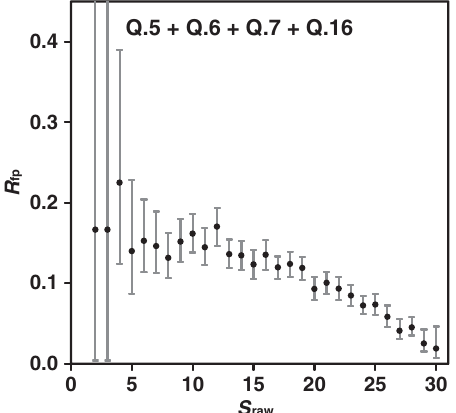
FIG. 6. The ratio of the sum of the systematic errors of Q.5, Q.6, Q.7, and Q.16 to a given raw score S for each group of raw students with that S . The error bars indicate the square-and-add raw intervals of the dependent variable for each